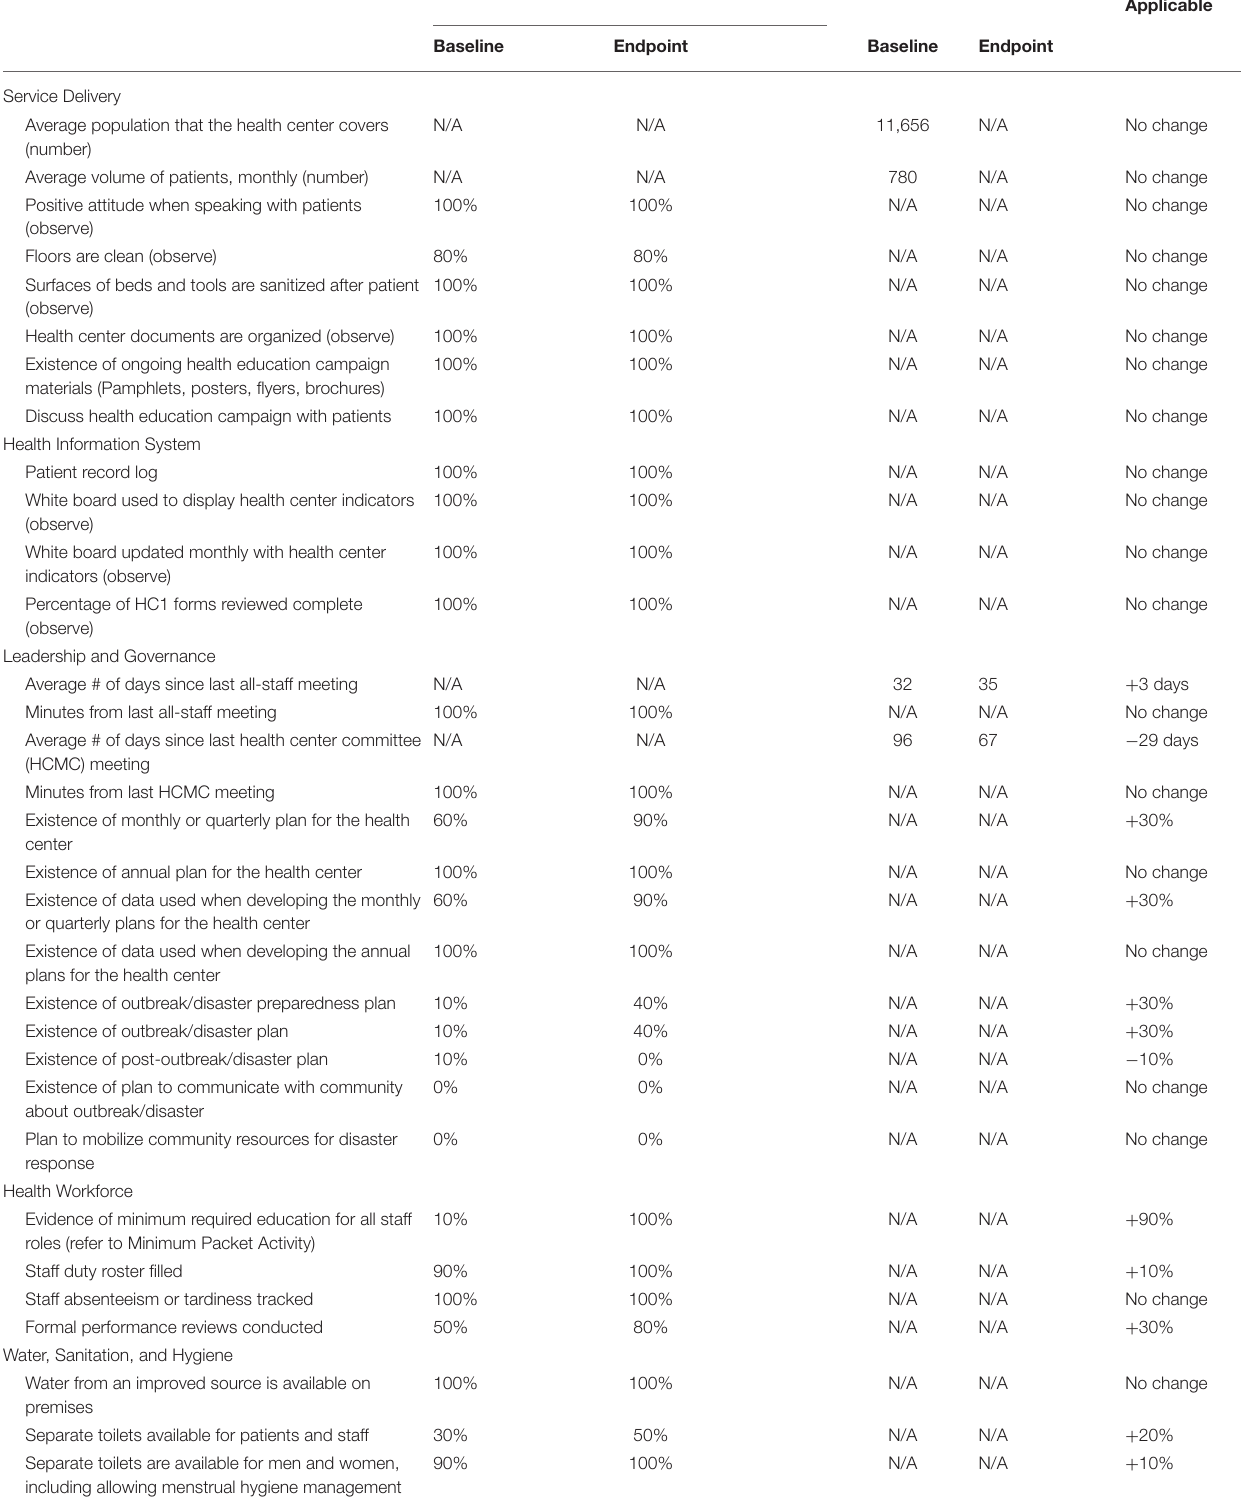
TABLE 3 | Change in indicators, from baseline to endpoint, of IMPACT Cambodia participants’ health centers, by health system category. Category and